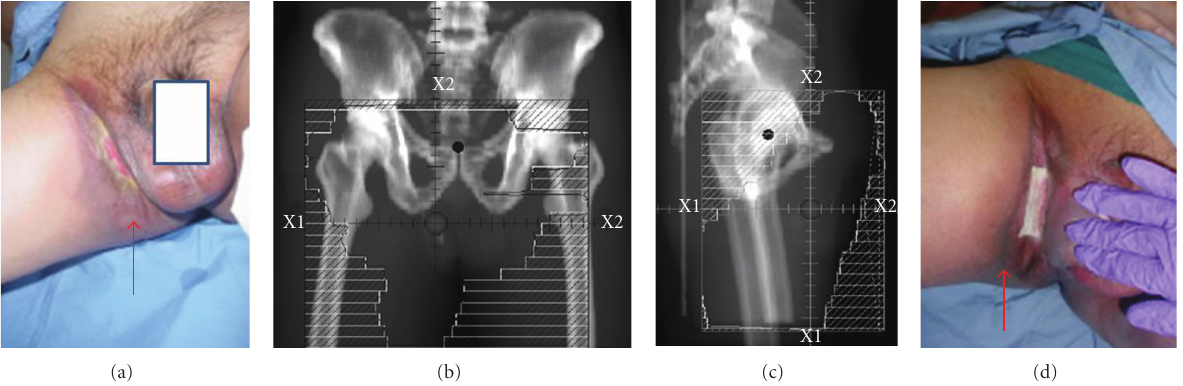
Figure 1: A 44-year-old male presenting with advanced RH of the pelvis and groin (a) Prior to treatment, arrow showing the extensive area of discoloration and skin breakdown (b) Anteroposterior (A-P) RT field (c) Lateral RT field (d) Groin in the last week of RT showing good clinical response (arrow) though skin break down persists probably secondary to RT. The skin healed within 4–6 weeks of completion of